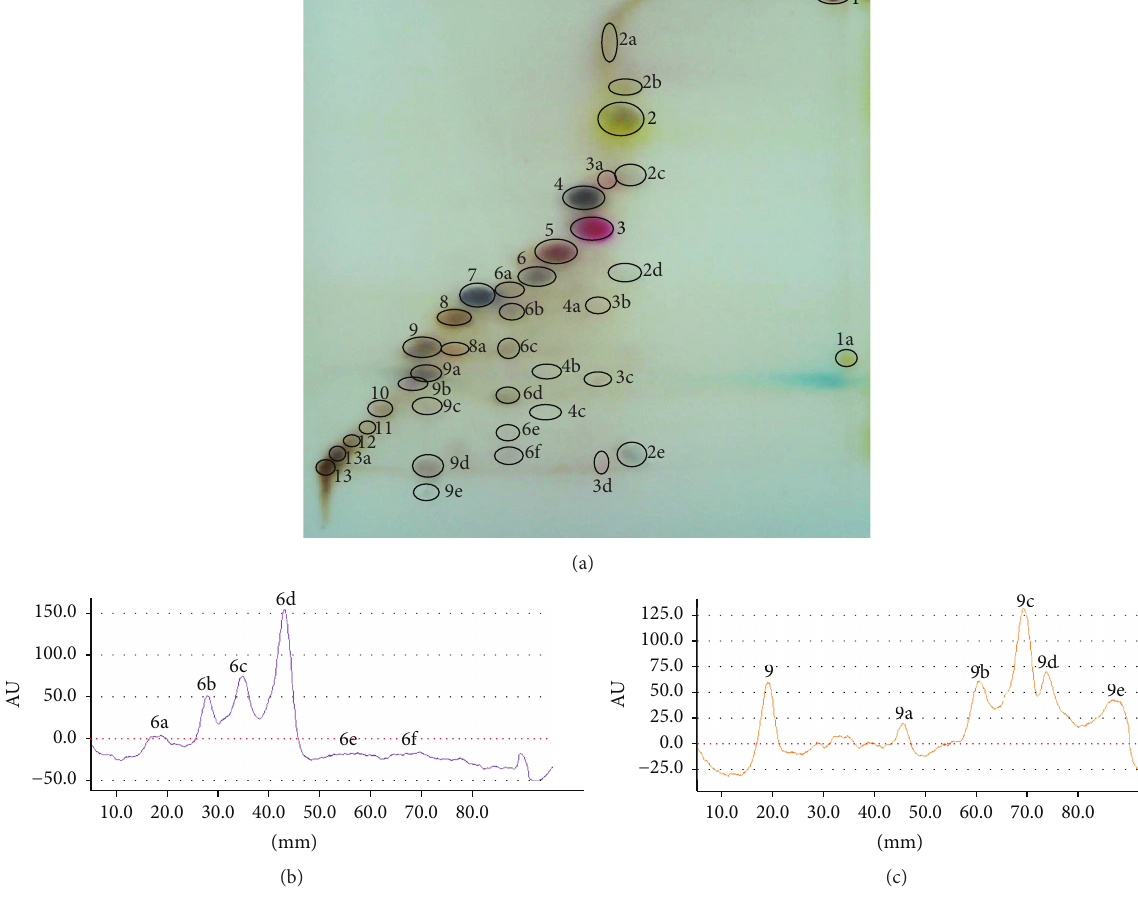
Figure 3: (a) MGD-2D TLC separation of Juniperi Oleum compounds. The program of eluent for second dimension development is presented in Table 1. The spots were derivatized with the anise aldehyde-sulphuric (VI) acid reagent. (b) Densitogram of the separation of compound 6 ( 𝑅 𝐹 = 0.43 from isocratic elution) into additional bands by means of MGD-2D-TLC. Peaks with 6e and 6f were not visible with the applied wavelength (560 nm). (c) Densitogram presenting the separation of compound number 9 ( 𝑅 𝐹 = 0.23 , from isocratic elution) into additional bands by means of MGD-2D TLC. Peaks with low 𝑅 𝐹 values, not marked on the densitogram, were not visible with the naked eye. Their detection was performed by densitometry at the wavelength of 560 nm (compare Figures 1 and